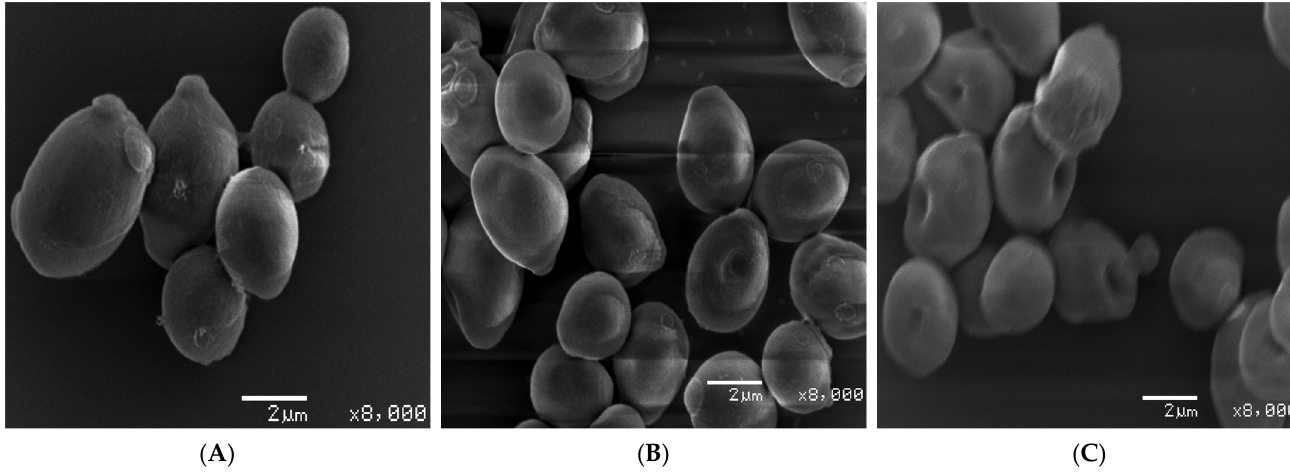
Figure 15. Scanning electron micrographs (SEM) of C. albicans SC5314: ( A ) represents untreated control cells whereas ( B ) and ( C ) represent the cells exposed to MIC and MFC of bio ‐ fabricated ZnONPs, respectively.